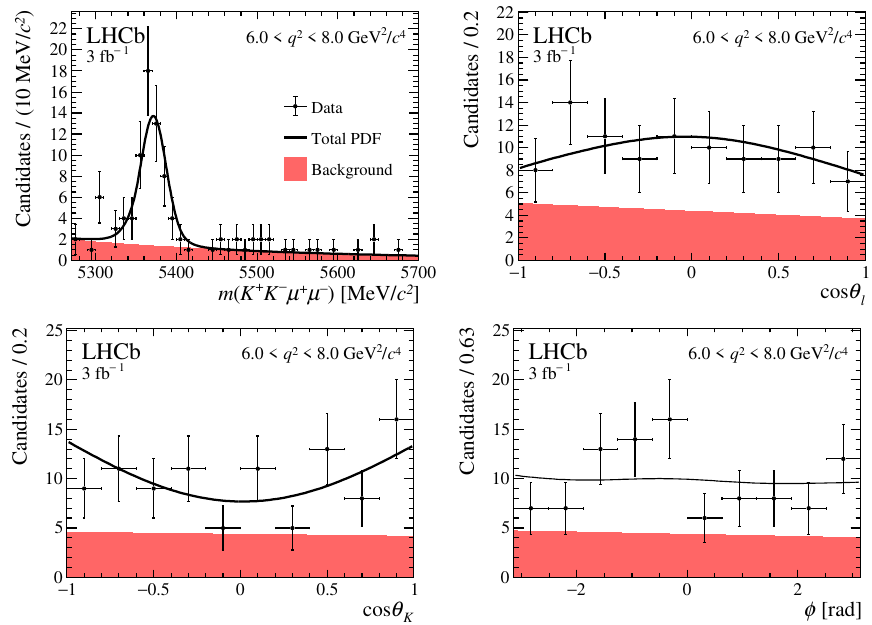
Figure 21 . Mass and angular distributions of B 0 6 . 0 < q 2 < 8 . 0 GeV 2 /c 4 for data taken in 2011–2012. The data are overlaid with the projections of the fitted